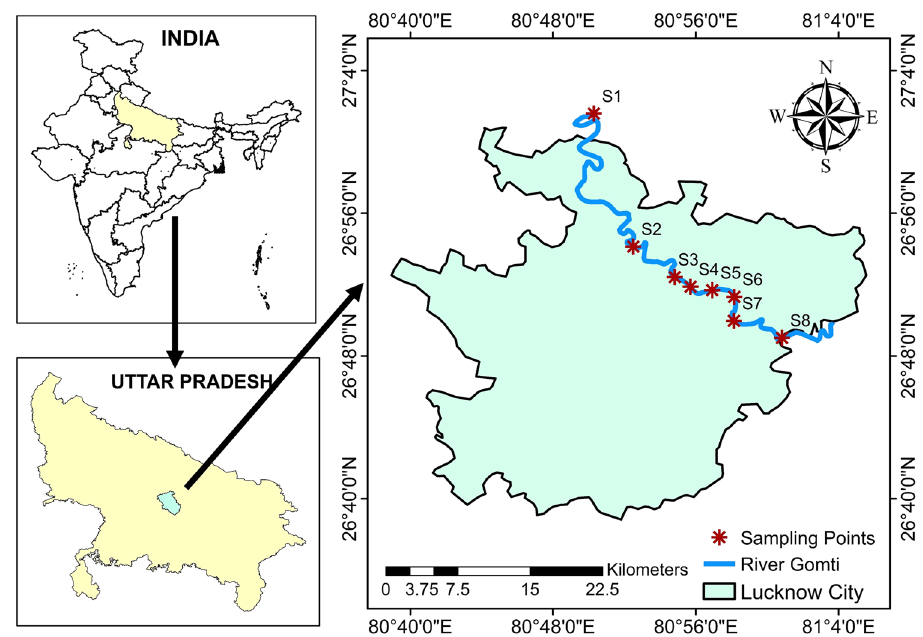
Fig. 1 Location map of sam- pling sites and River Gomti in Lucknow city, Uttar